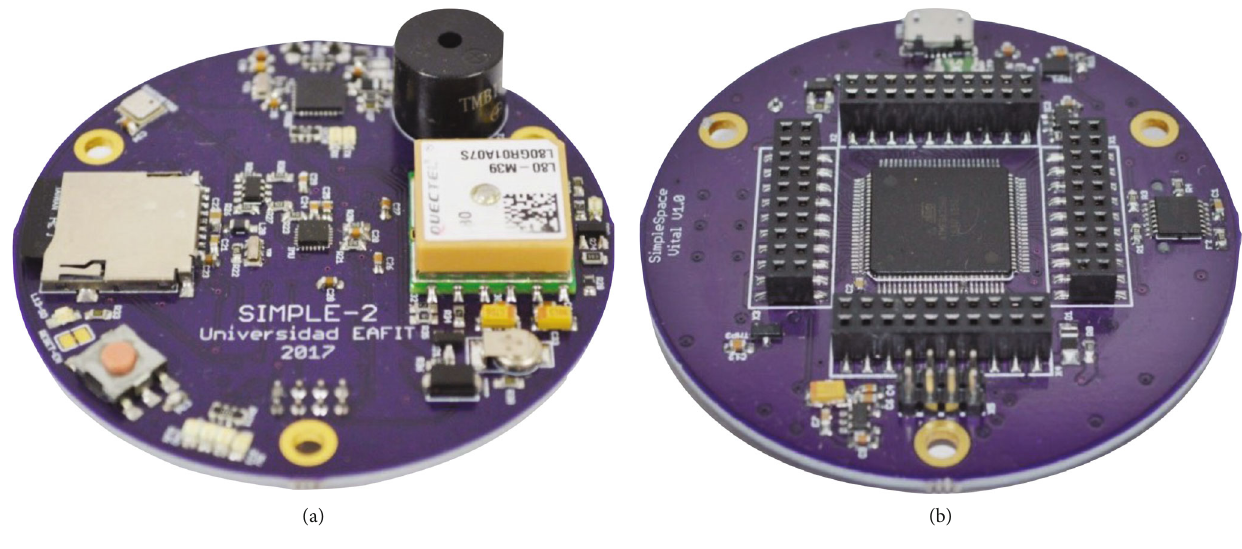
Figure 3: SimpleVital board interface top (a) and bottom